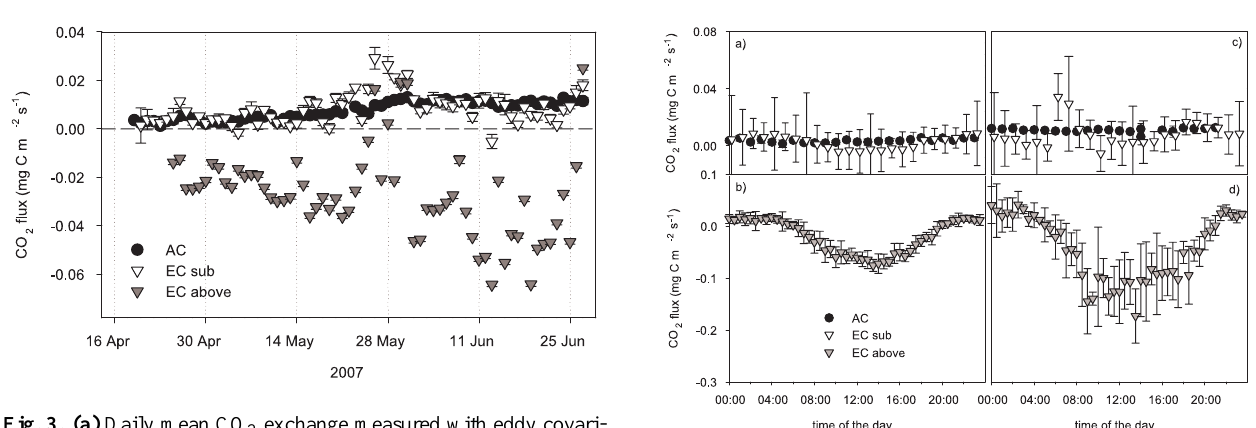
Fig. 3. (a) Daily mean CO 2 exchange measured with eddy covari- ance above the forest canopy (EC above) and inside the canopy (EC sub) and automatic chambers (AC) at the drained peatland pine for- est. Error bars stand for standard deviations.